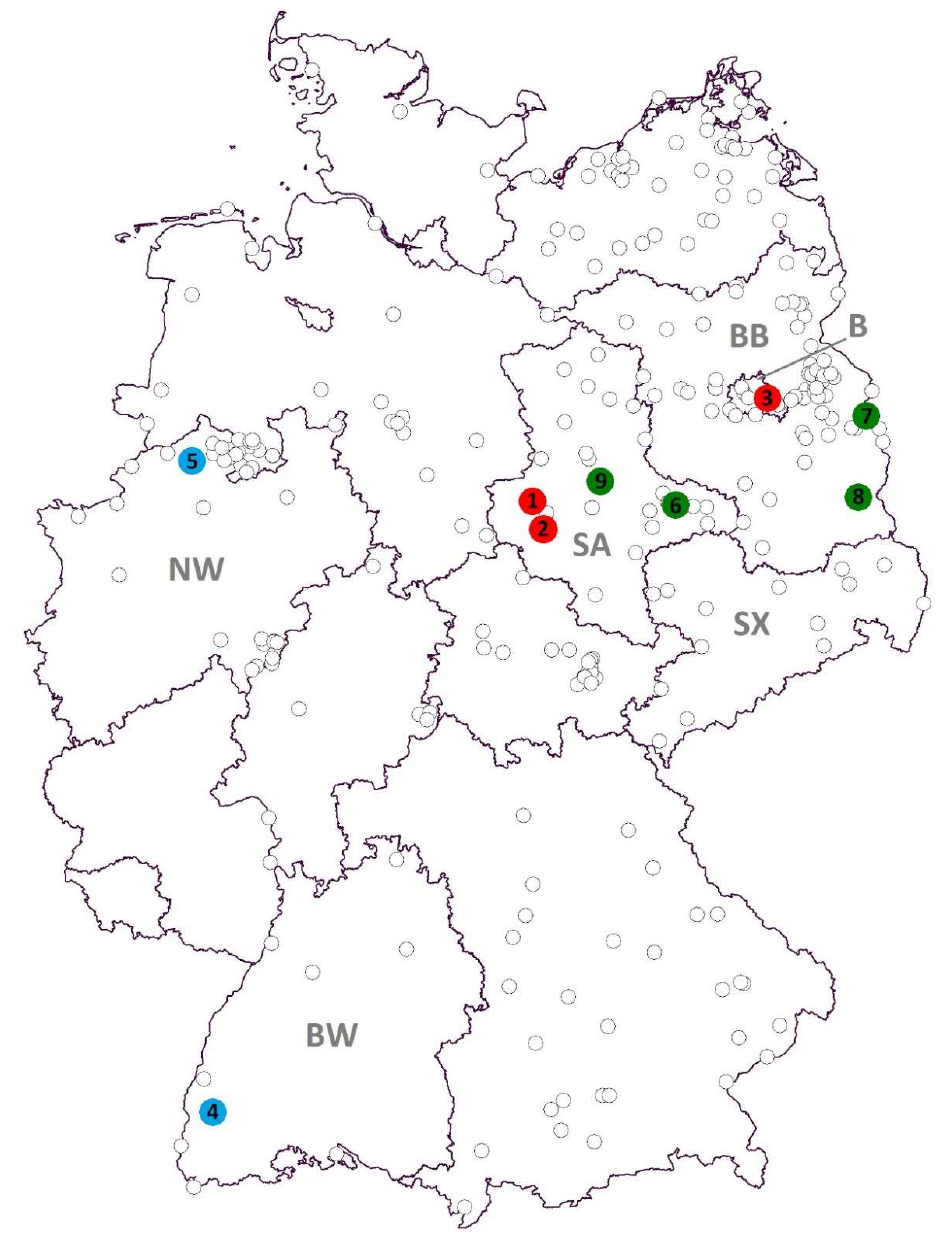
Figure 1. Mosquito sampling locations and viral RNA findings in Germany. Red = Sindbis virus (SINV), blue = Usutu virus (USUV), green = Batai virus (BATV), B = federal state of Berlin, BB = Brandenburg, BW = Baden-Wuerttemberg, NW = North Rhine-Westphalia, SA = Saxony-Anhalt, SX = Saxony.